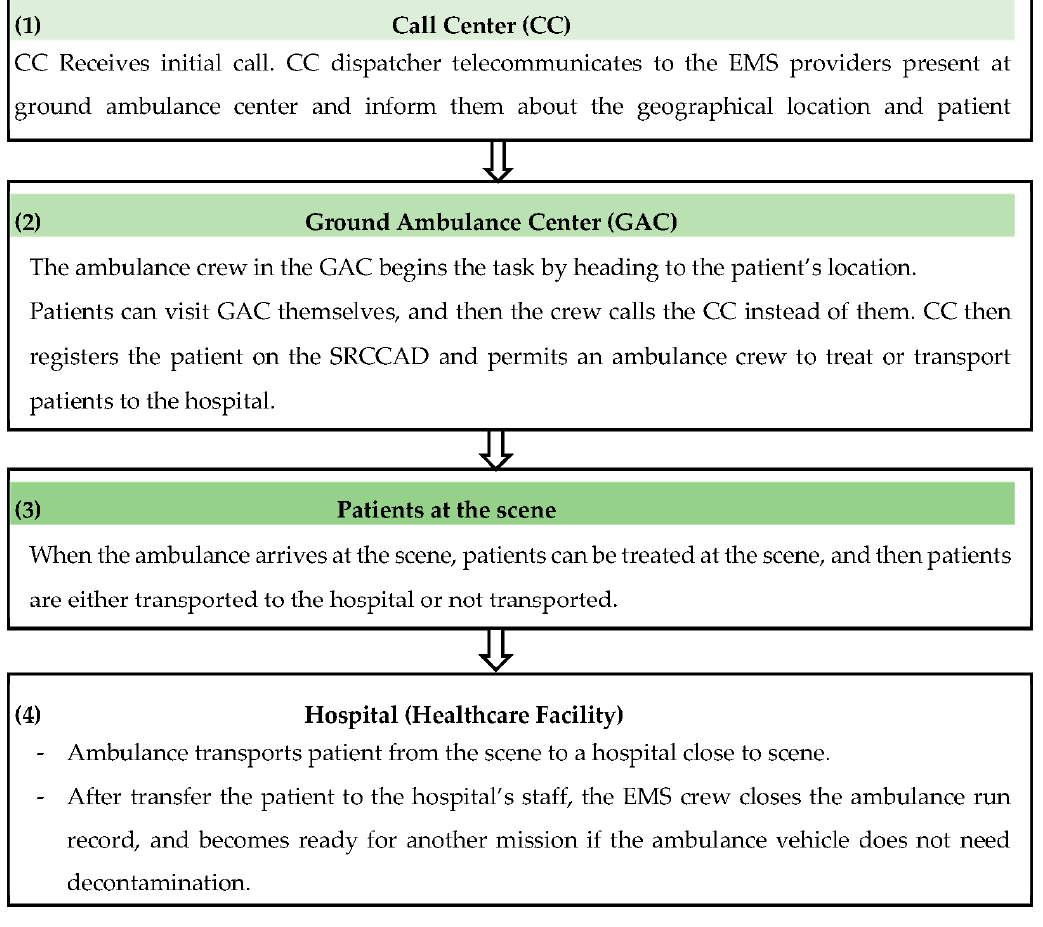
Figure 1. The Process Map of the Emergency Medical Services (EMS) Function in Riyadh Province for Every Single Ambulance Run.